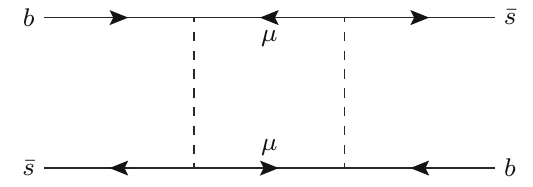
Fig. 2 Leading order Feynman diagram of LQ contribution to B s − ¯ B s